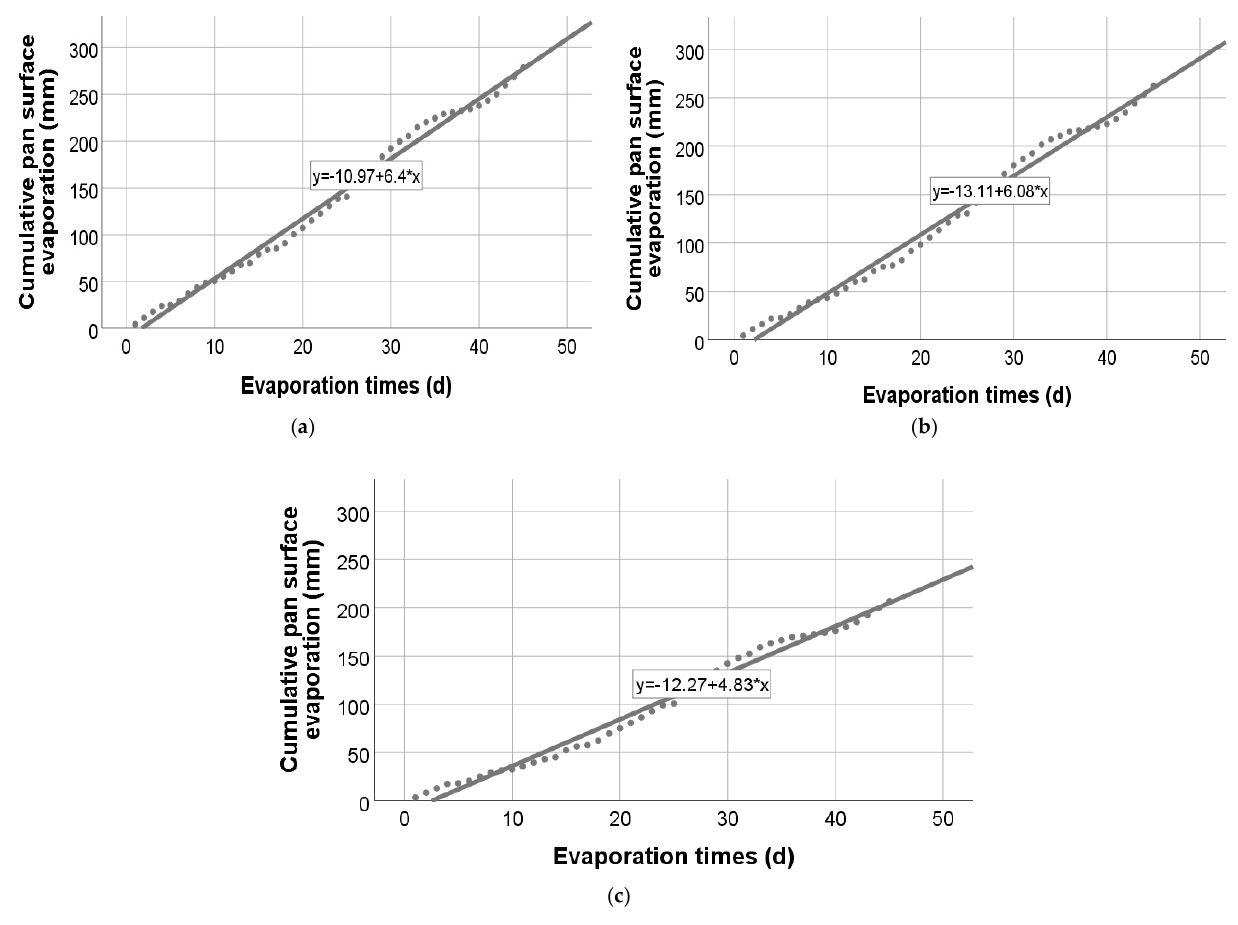
Figure 7. Cumulative pan surface evaporation and time under three treatments basis with the fitting equation in the ( a ) open-air, ( b ) under glass shed, and ( c ) a glass-shed covered with multilayer interference film. Table 6. The output of the SPSS shows the analysis variance (ANOVA a) of the three treatments.